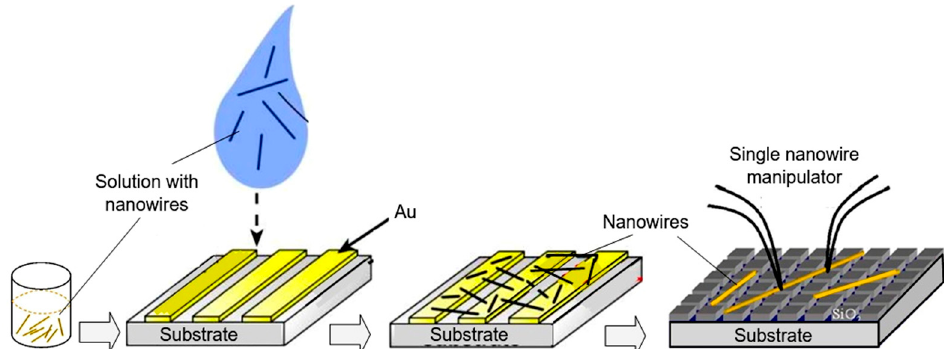
Figure 11. Illustration of the process of transferring 1D structures to the surface of the substrate: Nanowires are removed into a suspension of the solvent. A drop of the nanowire solution is dispersed on a template substrate and evaporated under a vacuum. Finally, nanowires with manipulator tips can be moved from a template substrate to the right place.